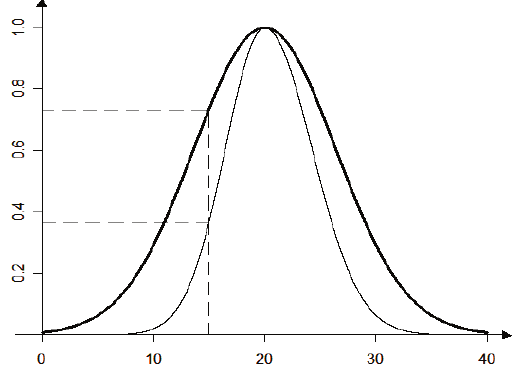
Fig. 1. Interval-valued fuzzy number in Example